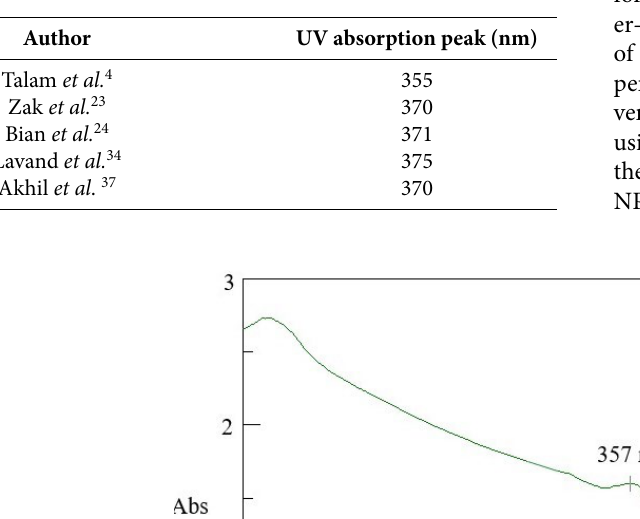
Table 3. UV vis absorption peak of ZnO from previous